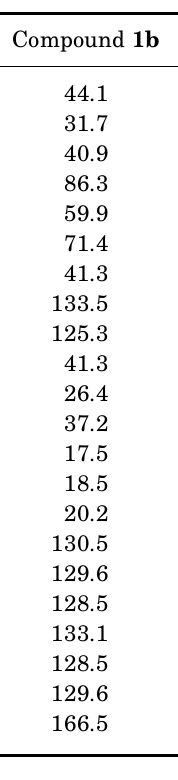
Table 3. 13 C-NMR data for compounds 1a and 1b